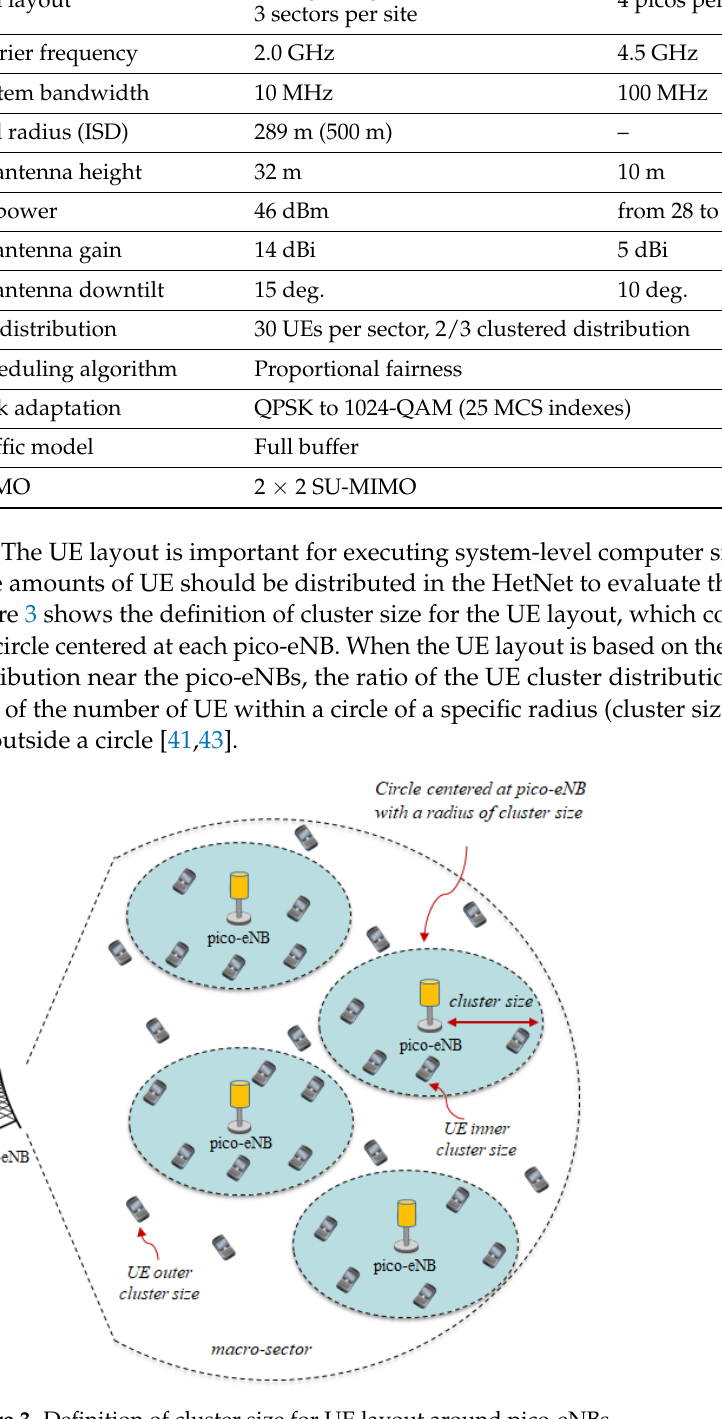
Table 1. Multiband HetNet model used in the simulation.